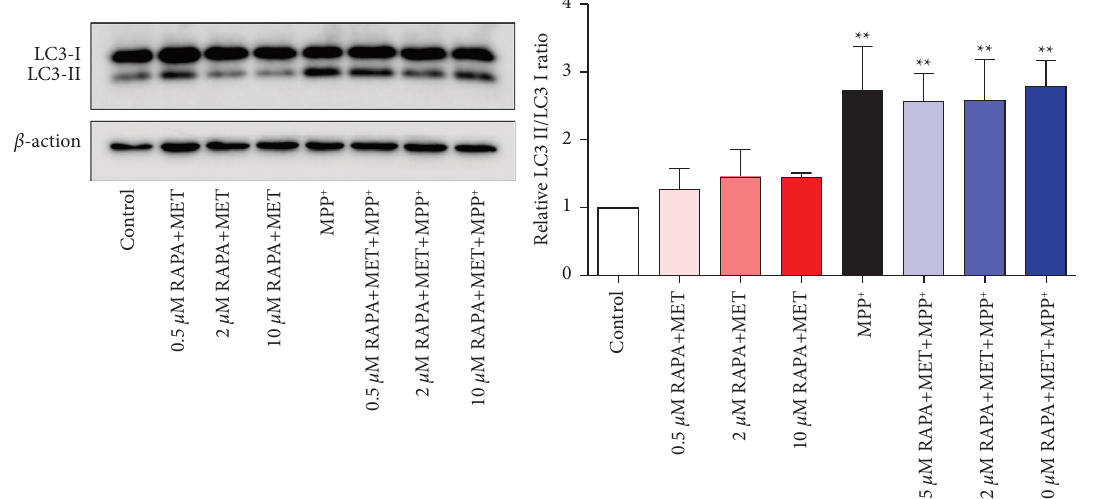
Figure 4: Western blotting analysis of LC3 expression in MPP + -treated diferentiated SH-SY5Y cells pretreated with MET and RAPA combinations. After pretreatment for 24hours, cells were exposed to 700 μ M MPP + for 24 hours. Quantifcation of the band density was normalized to β -actin. Values represent mean ± SEM. ( n � 3). ∗∗ p < 0 . 01 compared with the control